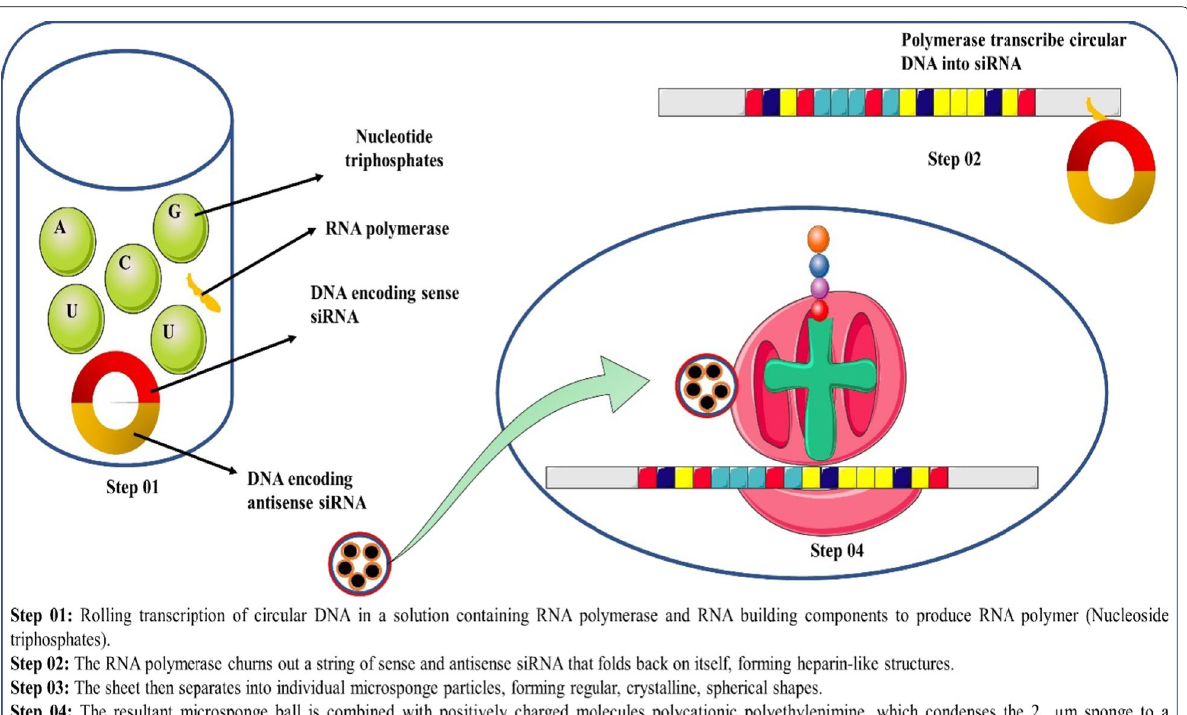
Fig. 19 Microsponges transport siRNA in a mechanistic